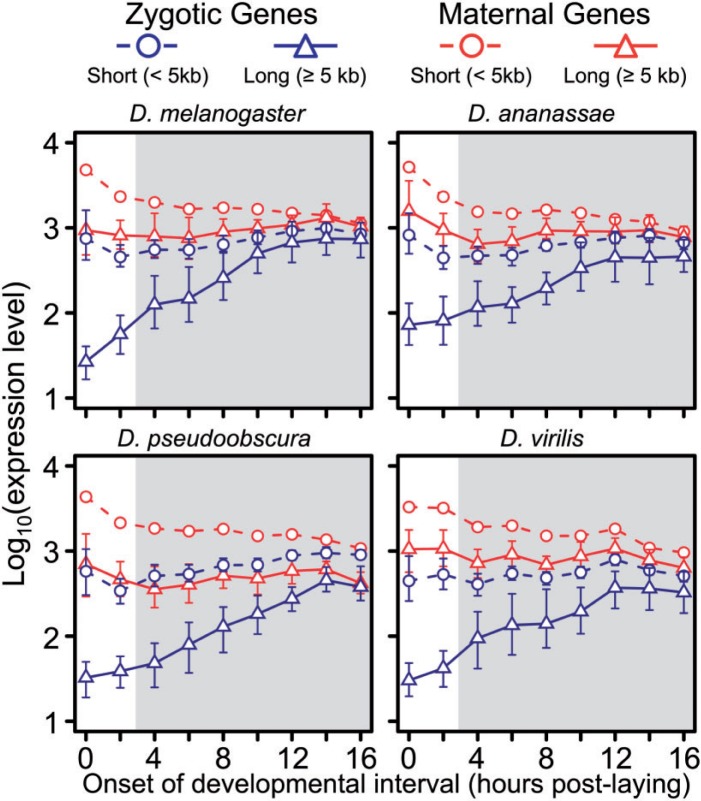
Patterns of delayed activation of long zygotic transcripts are consistent across Drosophila species. Median expression levels (with 95% confidence intervals) for Drosophila melanogaster zygotic (blue) and maternal (red) genes among the species of the four species microarray-based timecourse. Maternal and zygotic classifications are taken from D. melanogaster (Tadros et al. 2007). The area shaded in gray indicates postgastrulation time points during which the expression levels of maternally deposited genes may include significant contribution from zygotic transcription. Short genes (<5 kb) and long genes (≥5 kb) are indicated as circles and triangles, respectively. All three non-melanogaster species show patterns consistent with the RNA-seq based embryonic timecourse.